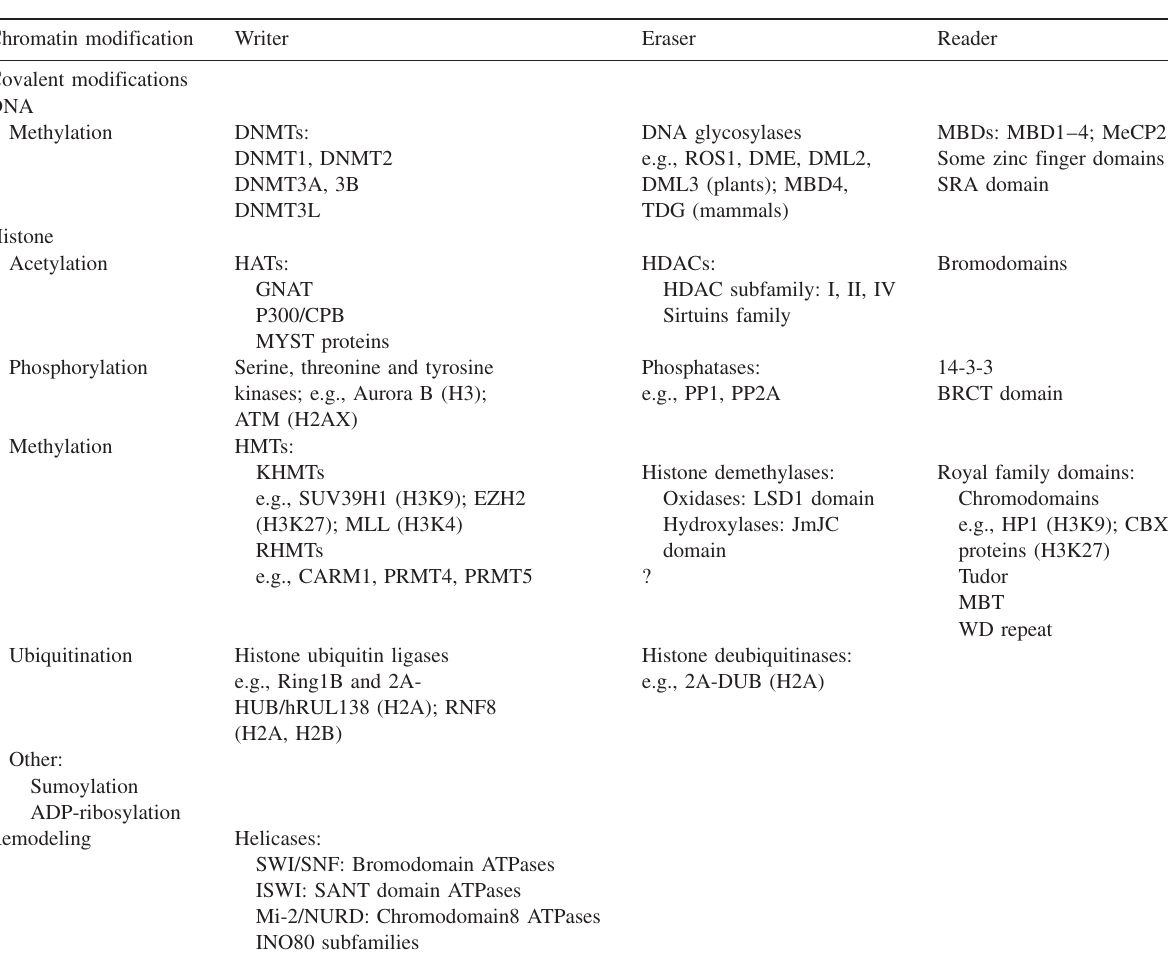
Table 1 Main classes of chromatin regulators and their